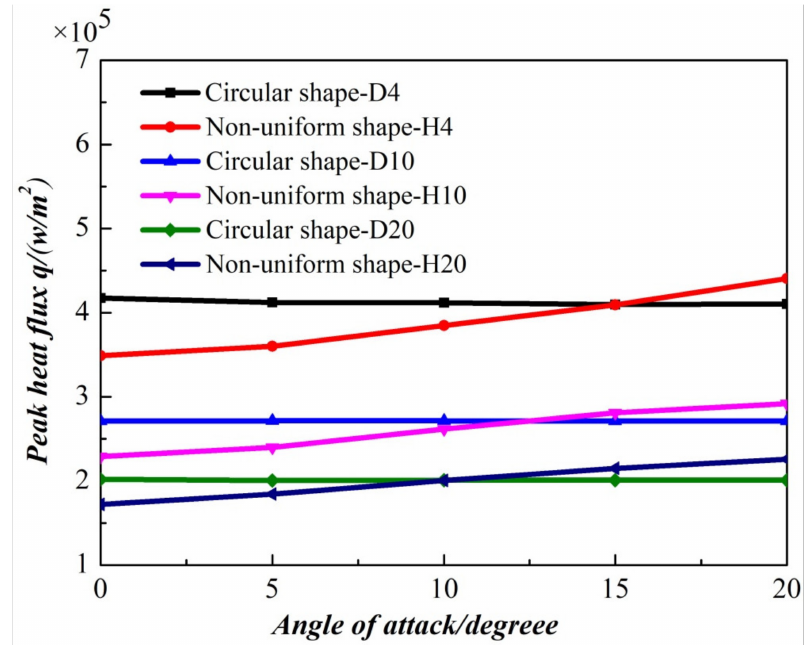
Figure 12. Peak heat flux of different blunt